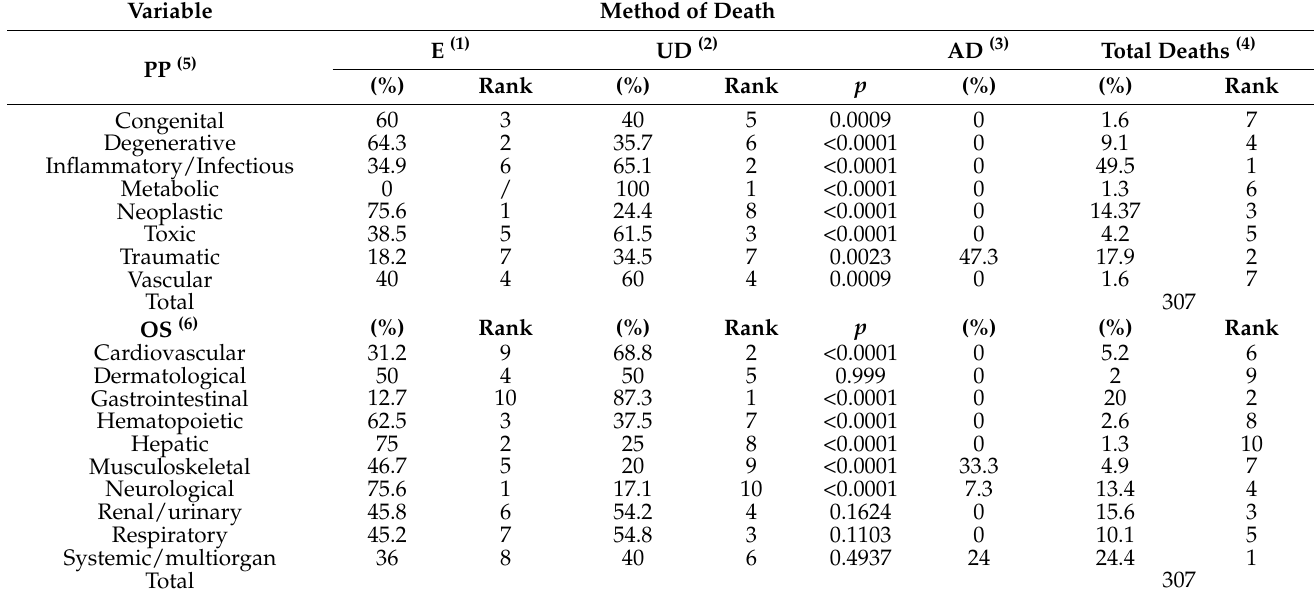
Table 1. Percentages and ranks for categorical variables and p -values for comparison between E and UD.